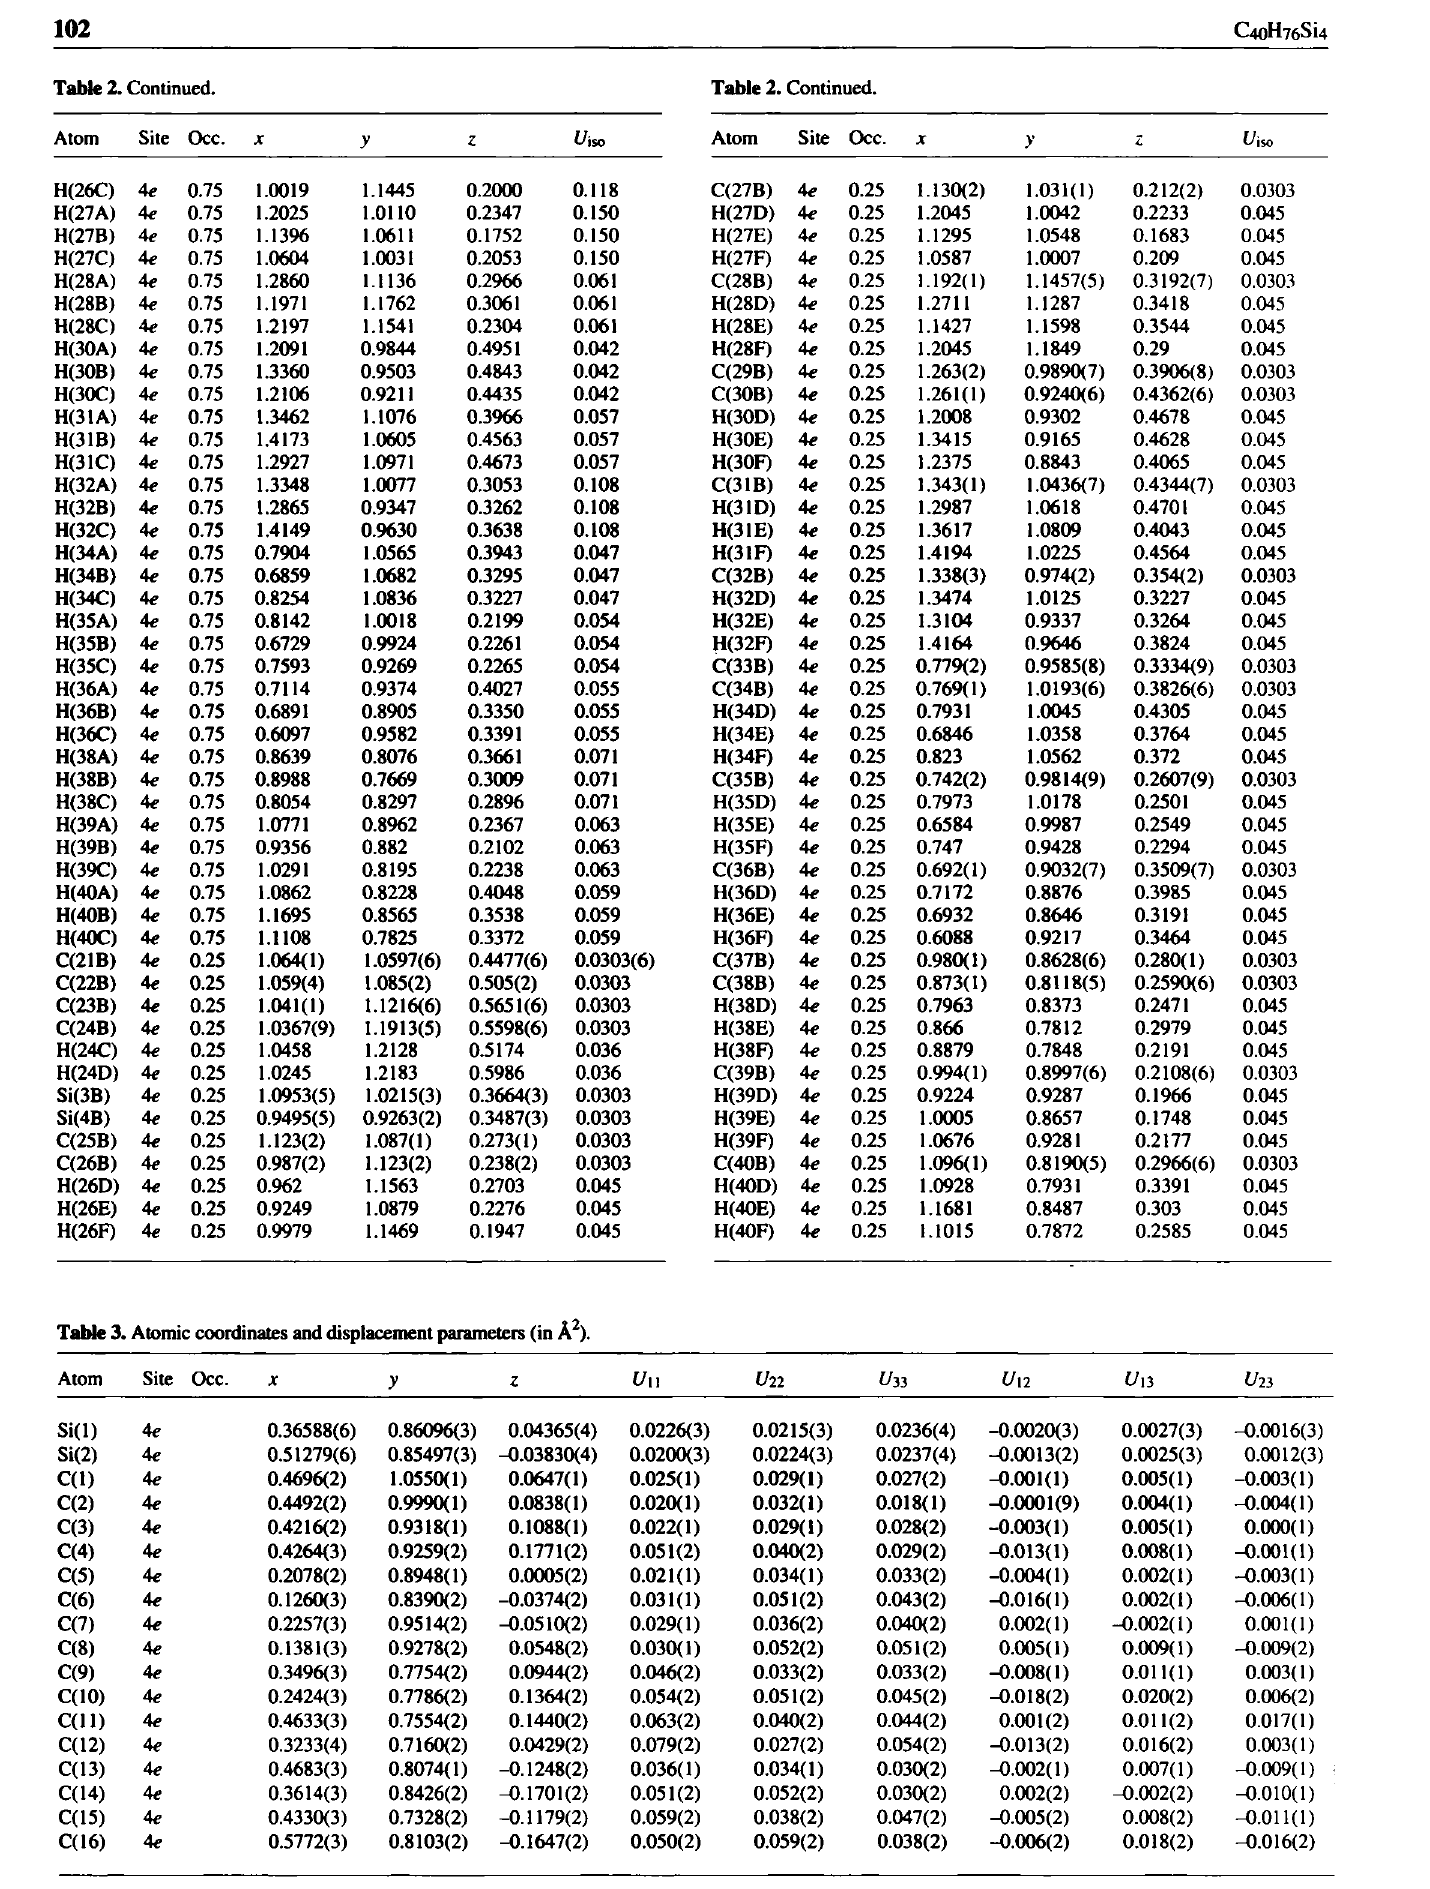
Table 3. Atomic coordinates and displacement parameters (in À 2